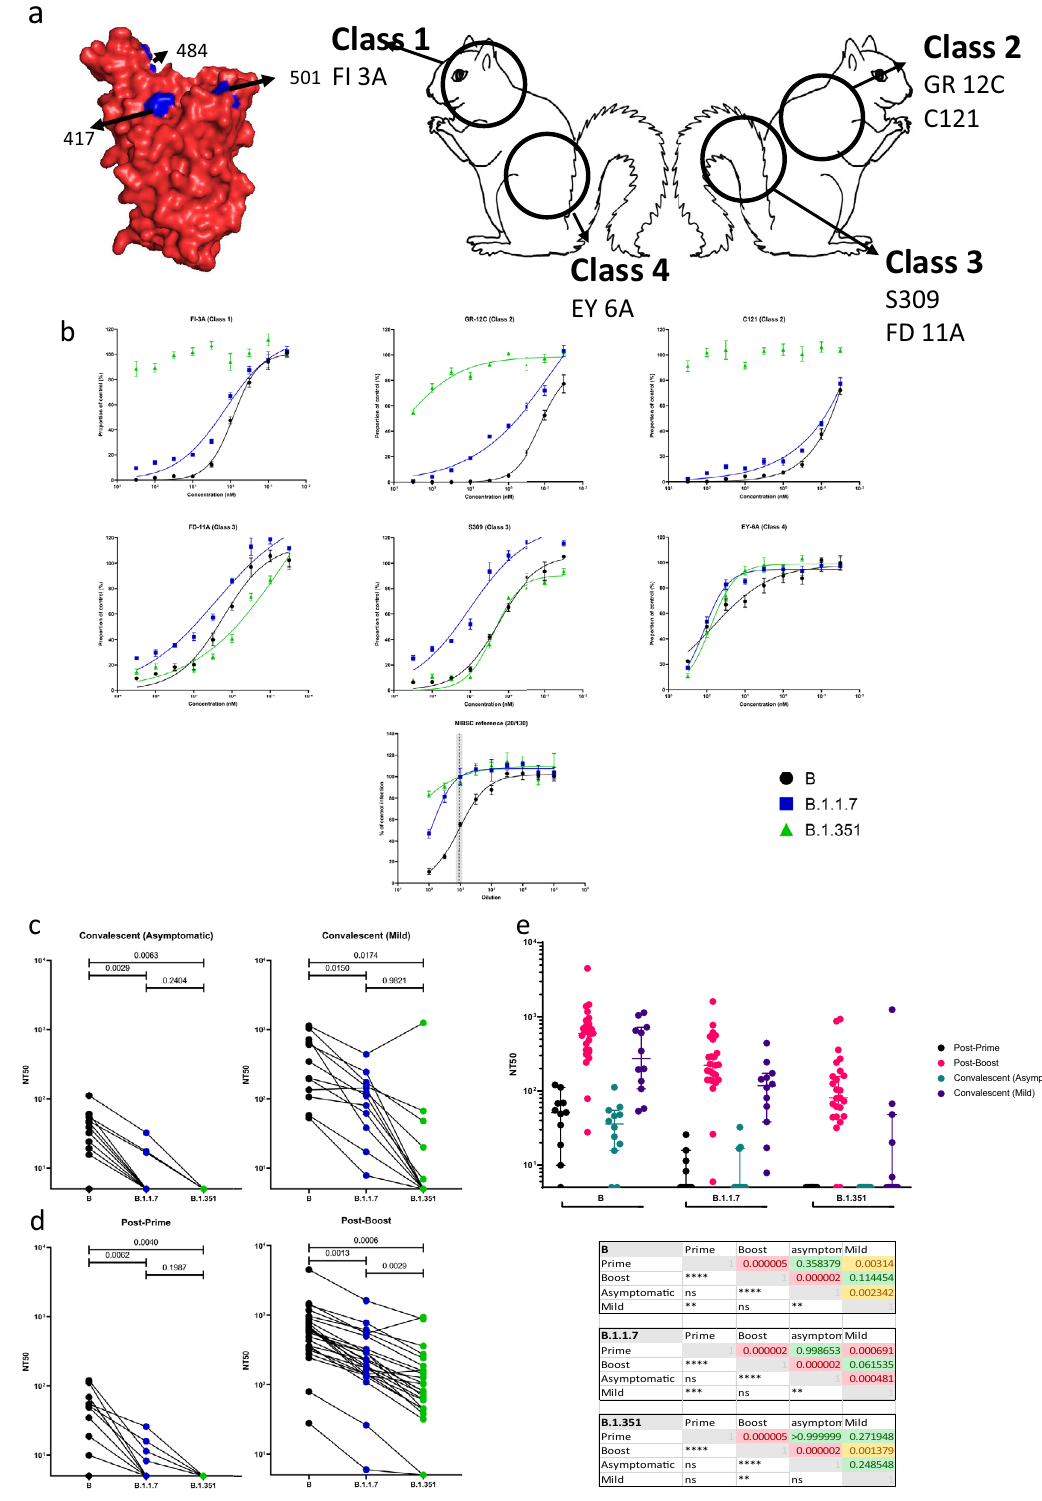
(IC50 = 1.365 nM) but does not neutralize B.1.351. Two other NmAbs, GR 12C and C121, that are Class 2 RBD binding mAbs (binding to the right side of the head of the squirrel), and which have homotypic IC50 ~0.1 nM, show some reduced effectiveness in neutralizing B.1.1.7 and have lost almost all potency against B.1.351. This might be expected, as class 2 antibodies bind to an epitope that includes residue 484 (reviewed by refs. 47 , 48 ). In